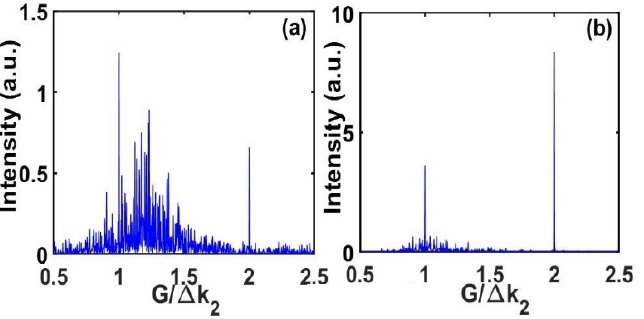
Figure 8. The Fourier transforms of the δ ( z) functions of the designed nonlinear lattices. ( a , b ) refer to the dimensionless case for ( a ) different (Figure 2) or ( b ) equal (Figure 3) domain sizes in each segment.